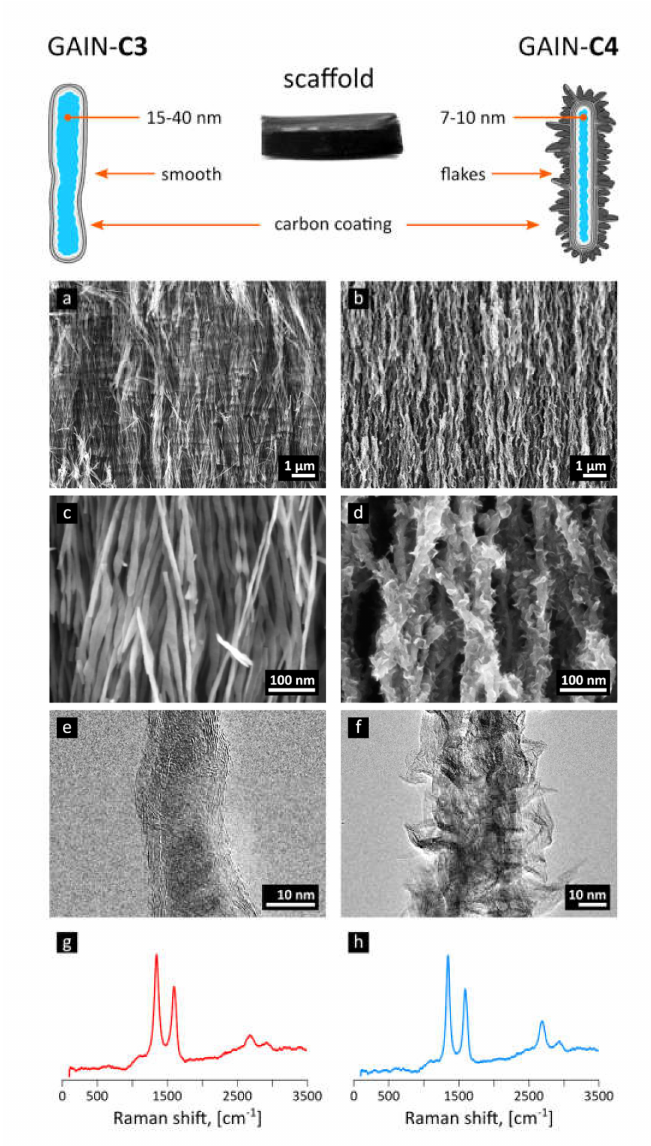
Figure 1. The schematic representation of synthesized GAIN scaffolds and their structure from SEM and TEM images for the type “C3” ( a , c , e ) and “C4” ( b , d , f ), together with their respective Raman spectra ( g , h